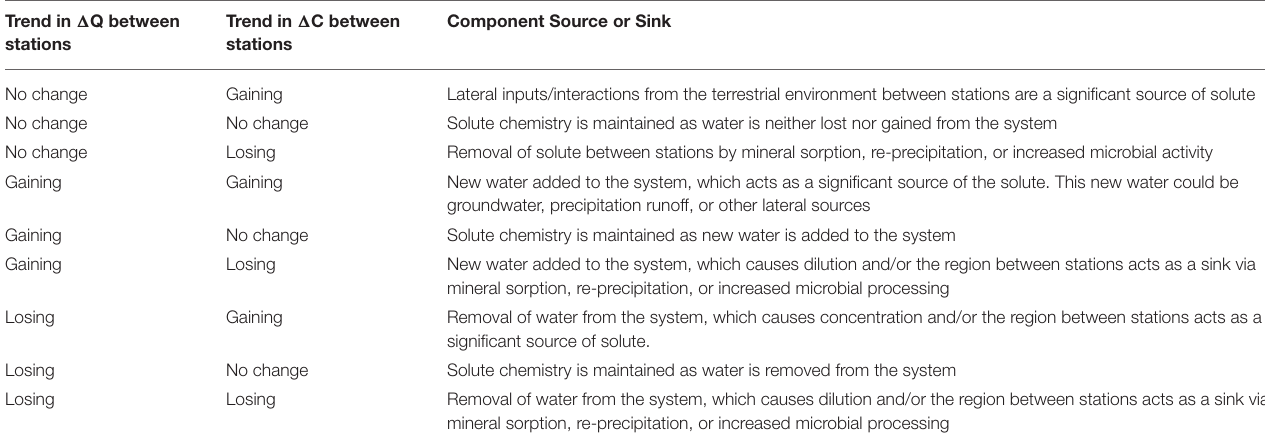
TABLE 1 | Analysis and interpretation of differential concentration-discharge relationships. Trend in 1 Q between